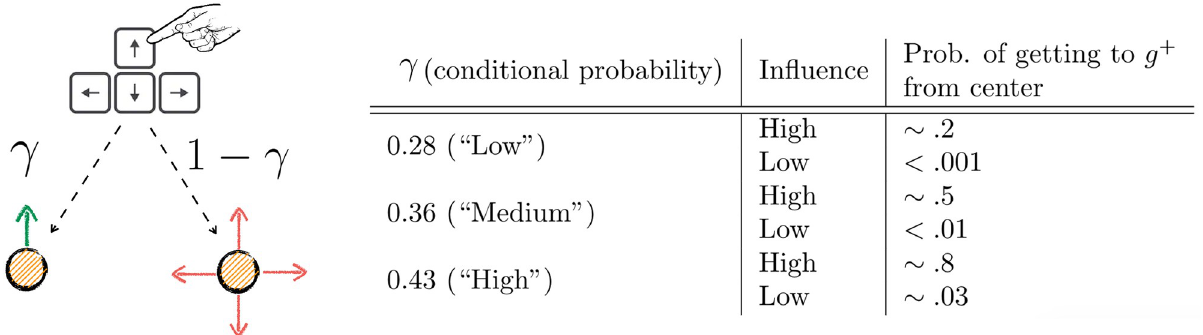
Fig 4. The design of guidability. The figure on the left hand side depicts the relationship between miroscopic actions and outcomes with respect to the conditional probability γ . On pressing (for instance) the upwards arrow key, the vehicle (small yellow circle) follows the direction verbatim with probability γ (left; green arrow) or goes in a direction sampled uniformly at random (right; red arrows). On the right hand side, a table describes what the three different values for γ imply when a vehicle placed at the center of the canvas is set to reach g + , according to whether influence conditions are high or low. Reaching g + from the center of the canvas in low influence conditions is almost impossible.The choice of guidabilities implied substantially different probabilities of reaching a goal from the central position (using the central vehicle) in high influence blocks. For instance, pressing consistently at a frequency of 8 Hz for the full duration of the trial (14s) would yield probabilities 0.8 (“High”), 0.5 (“Medium”), and 0.2(“Low”). In low influence blocks, the chance of making a goal using the central vehicle was circa 0.03 (“High” guidability) and fell substantially below 0.01 when guidability is “Medium” and “Low”. These numbers are Monte Carlo estimates obtained via empirical simulations, which assumed an optimal strategy of pressing, consisting of moving the vehicle only in the direction of the goal in the allotted time, at the maximum frequency allowed (8 or 4 Hz according to influence condition). Note that while we used empirical probability of reaching the goal from the central position to inform the value of guidability, we did not use it to determine the relative positions of the other vehicle.